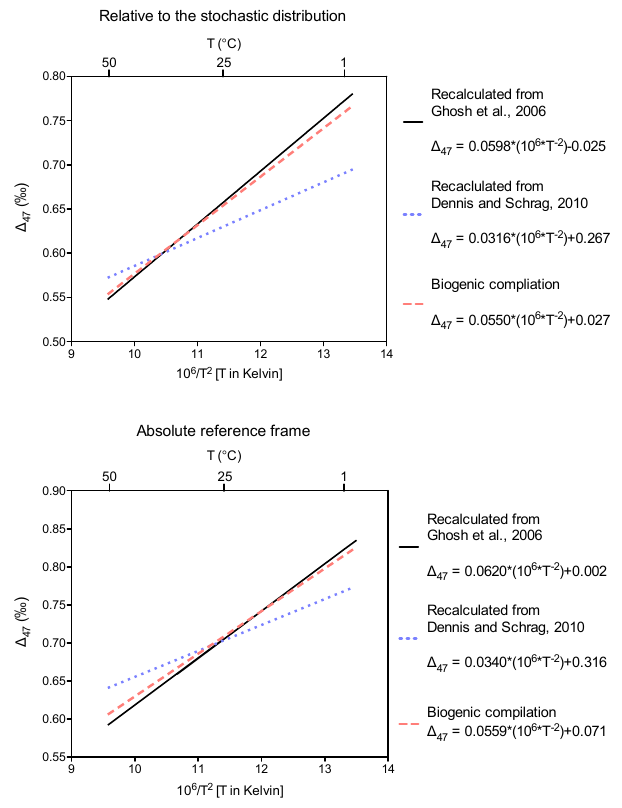
Fig. 1. Published calibrations of the carbonate clumped isotope ther- mometer. The top panel shows previously published inorganic cal- ibration lines relative to the stochastic distribution, as described by Huntington et al. (2009) as well as a recalculation of the regression through the data compilation of Tripati et al. (2010) which drew on several original sources (Ghosh et al., 2006, 2007; Came et al., 2007; Eagle et al., 2010; Tripati et al., 2010); and now has the data from Thiagarajan et al., included (Thiagarajan et al., 2011). Data from Zaarur et al., was not included due to uncertainties over ex- actly what environmental conditions the materials analyzed should reflect (Zaarur et al., 2011), and the Porites coral analyzed by Ghosh et al., was also excluded due to apparent kinetic isotope effects on 1 47 values (Ghosh et al., 2006). Also shown is a regression through the same compilation of published materials now converted into the absolute reference frame (Table S1) via the secondary transfer function method (Dennis et al., 2011). Note that the 10 6 /T 2 scale with T in degrees Kelvin is the primary temperature scale used for data plots, with a secondary x-axis in degrees Celsius presented as a guide only. All regression lines were recalculated from original data (see methods for